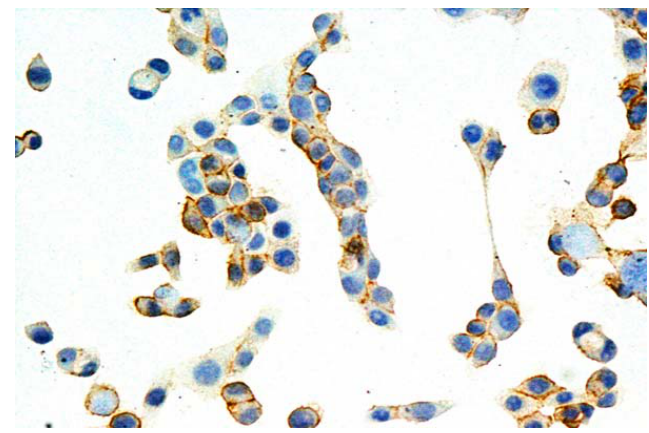
Figure 2. Expression of P-gp in membranes of cells in EPG85-257RDB line, subjected to action of Q12/K1. × 200.